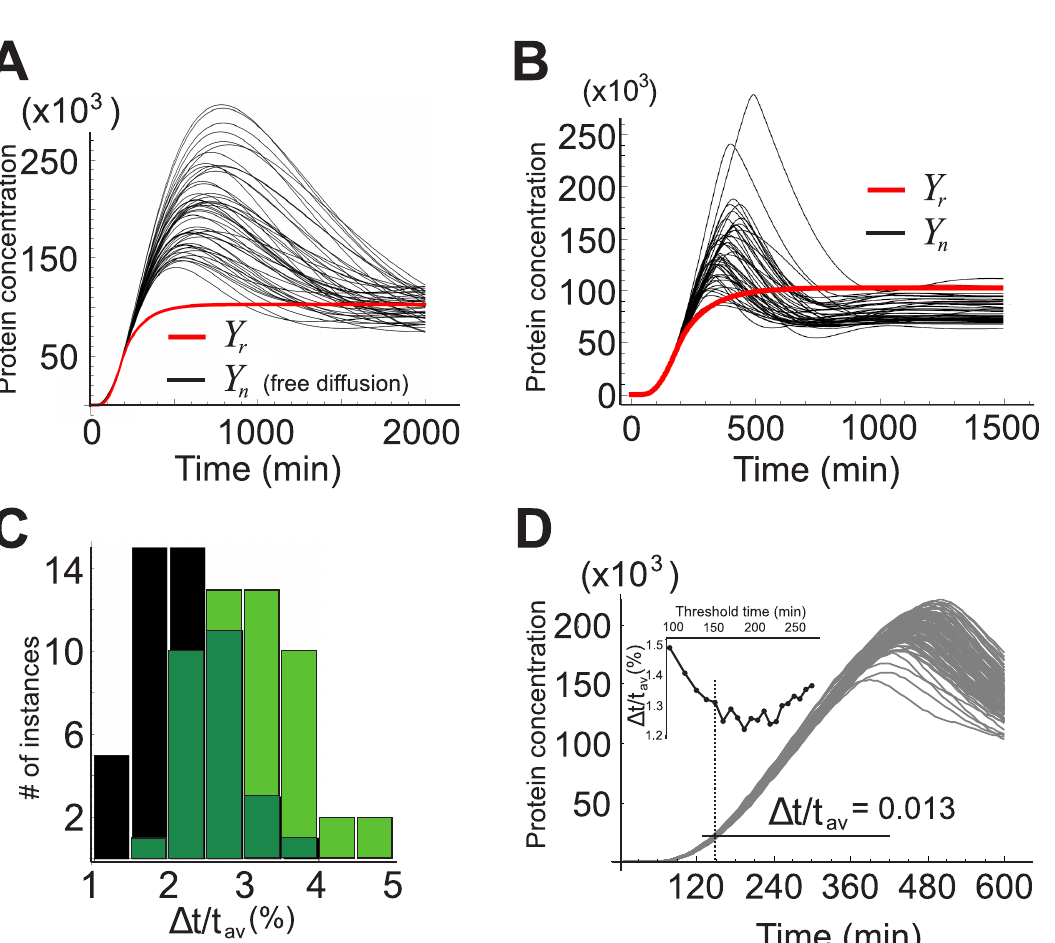
Fig 4. Results for the simple and the extended models. Profiles for the nuclear concentration corresponding to the 50 parameter sets for A) the simple model, and B) the extended model. In red is the reference curve Y r . C) Distribution of threshold times for the simple model (green) and the extended model (black). D) Superposition of 100 realizations for the best case offered by the extended model: Δ t / t av = 0.013. The smaller plot within shows values of Δ t / t av for different threshold times t av .